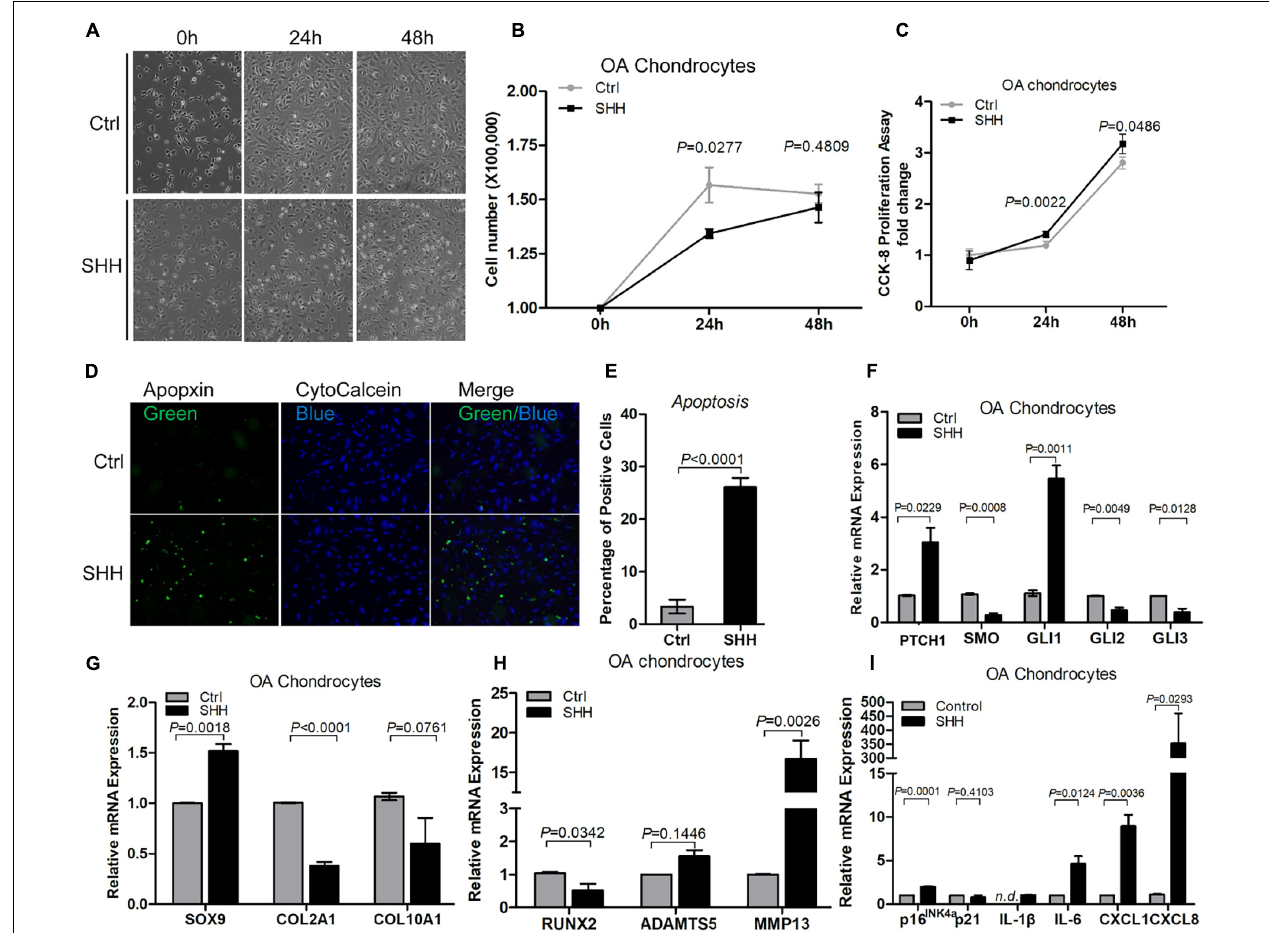
FIGURE 4 | Sonic hedgehog (SHH) induced chondrocyte apoptosis and gene expression of the markers of hedgehog (HH) signaling, catabolism, senescence, and senescence-associated secretory phenotype (SASP) in chondrocytes. (A) Micrographs of primary osteoarthritic chondrocytes (OACs) and their treatment with human SHH recombinant protein for 24 and 48 h. SHH treatment induced shrunken cell shape and cell detachment. Images are representative of cell culture samples in triplicates. Scale bar = 125 µ m. (B) Cell number change of OAC in response to human recombinant SHH incubation for 24 and 48 h. n = 4 individual biological samples. (C) Cell proliferation rate of OAC in response to human recombinant SHH incubation for 24 and 48 h. Cell proliferation rate was quantified by the CCK-8 proliferation assay. n = 5 biological replicates. (D) Fluorescence cytochemical analysis of chondrocyte apoptosis induced by human recombinant SHH. Live chondrocytes were stained blue with CytoCalcein Violet 450, while apoptotic cells were stained green with Apopxin green indicator. Scale bars = 125 µ m. (E) The percentage of OAC apoptosis induced by human recombinant SHH. n = 4 individual biological samples. Real-time reverse transcriptase-polymerase chain reaction (RT-PCR) analysis of transcripts encoding markers of HH signaling (F) chondrogenesis (G) , catabolism (H) , and cell senescence and SASP (I) in primary OAC. Ctrl, Control (mock